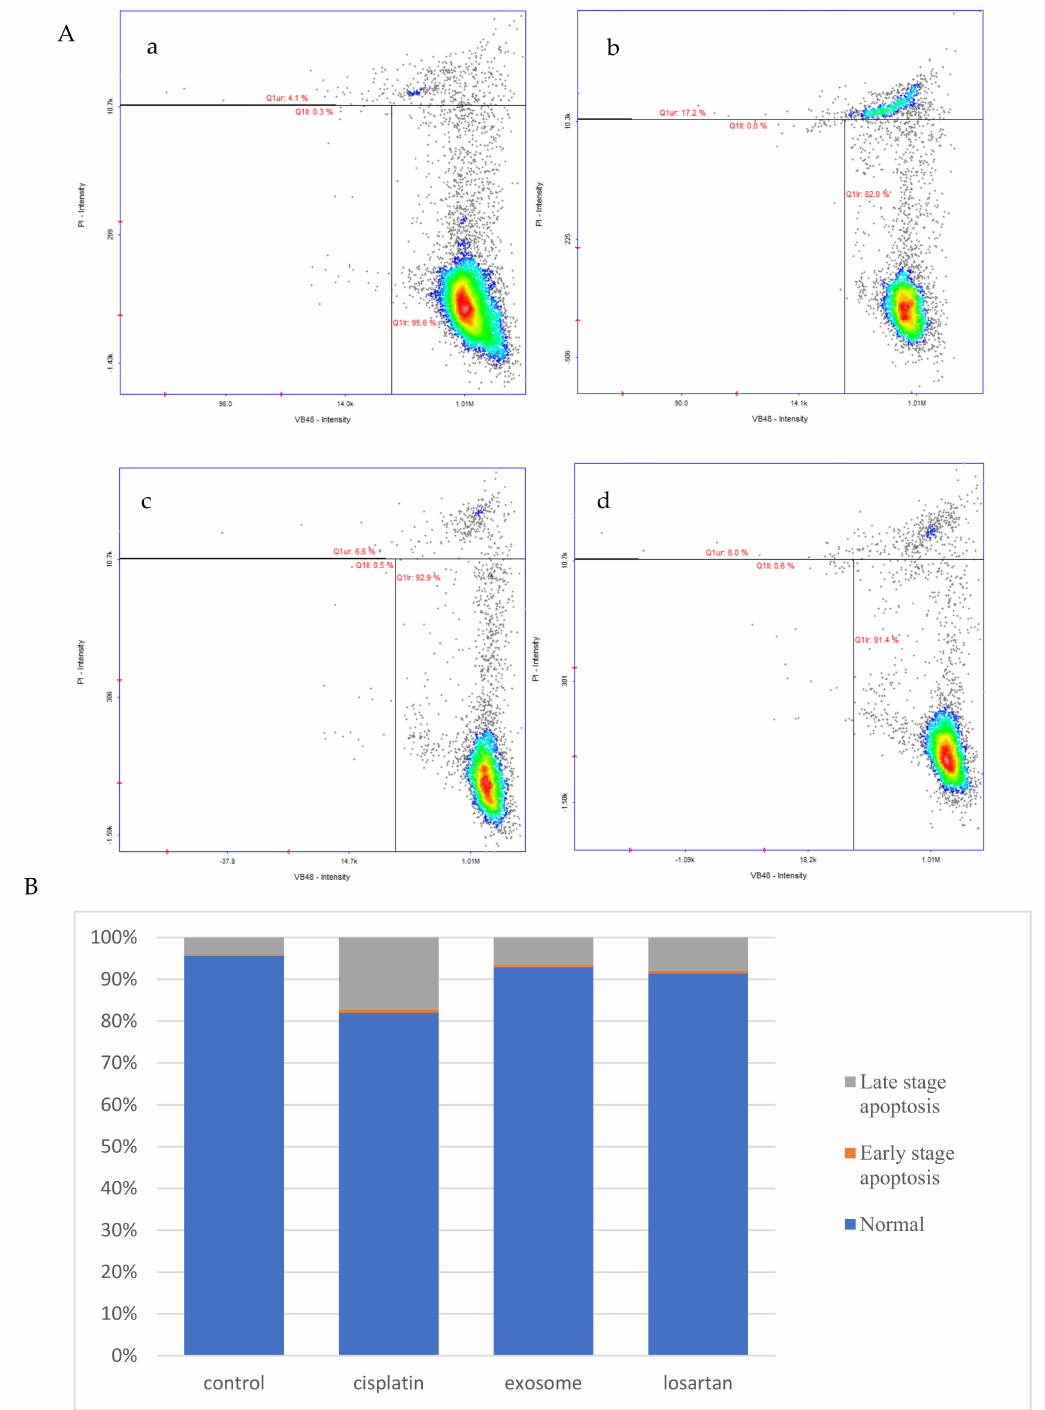
Figure 4. Distribution of normal and early/late apoptotic NRK-52E cells treated with or without cisplatin, SCPA-ex, and/or losartan ( A ), ( a ) control group, ( b ) cisplatin group, ( c ) exosome group and ( d ) losartan group; the lower right is normal cells, the lower left and upper sides of panels represent the early and late stages of apoptosis, respectively. Percentage of normal, early, and late apoptotic NRK-52E cells treated with or without cisplatin, SCPA-ex, and/or losartan ( B ). SCAPs, stem cells from the apical papilla; SCAP-ex, SCAP-derived